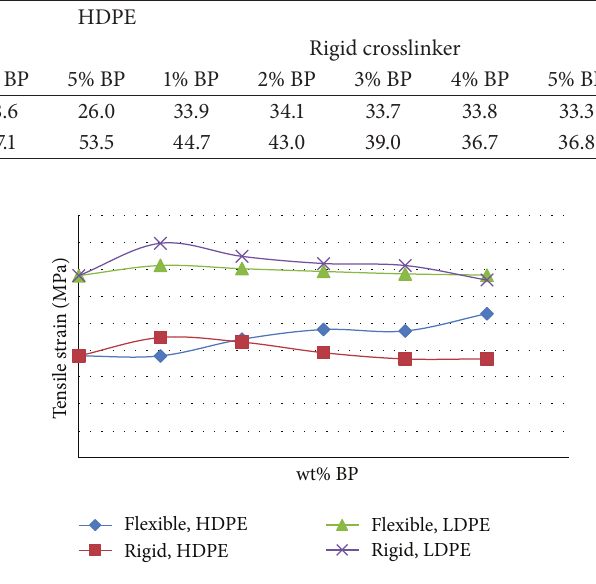
Figure 5: Tensile strains for all specimens injected at respective compositions.